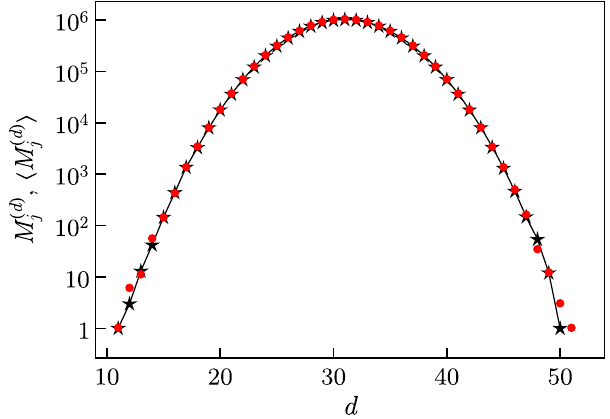
FIG. 9. Red points show the empirical probability distribution P δ ð d − d Þ . Here, d M M ð d Þ vs d with M ð d Þ is a matrix of ¼ ij ij j j j ¼ 1 between the set of M randomly chosen Hamming distances d ij n -bit strings (marked states), and i is a randomly chosen marked state. The distribution corresponds to M ¼ 10 7 and n ¼ 60 . Black stars connected by a black line show the samples m d from multinomial distribution with mean values h M ð d Þ i ¼ Mp d , j is binomial distribution where p d